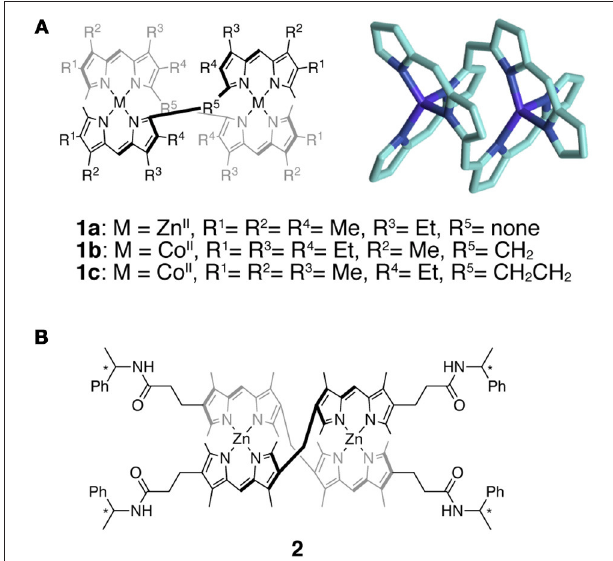
FIGURE 2 | (A) (left) Chemical structures of double helicates 1a – 1c . (right) Molecular structure of 1b determined by X-ray crystallography. Hydrogen atoms and peripheral methyl and ethyl substituents are omitted for clarity. (B) Chemical structure of the double helicate 2 bearing homochiral amide